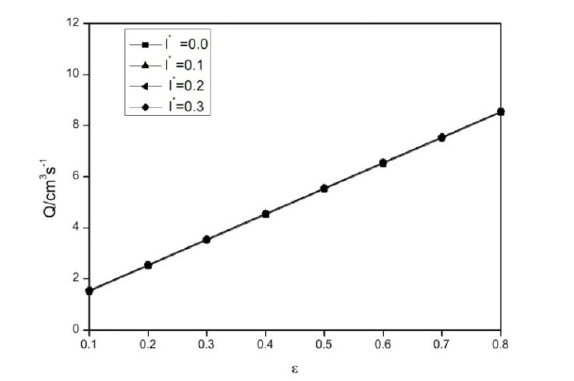
Fig. 8: Side leakage versus eccentricity ratio for different values of the couple stress parameter with roughness parameter